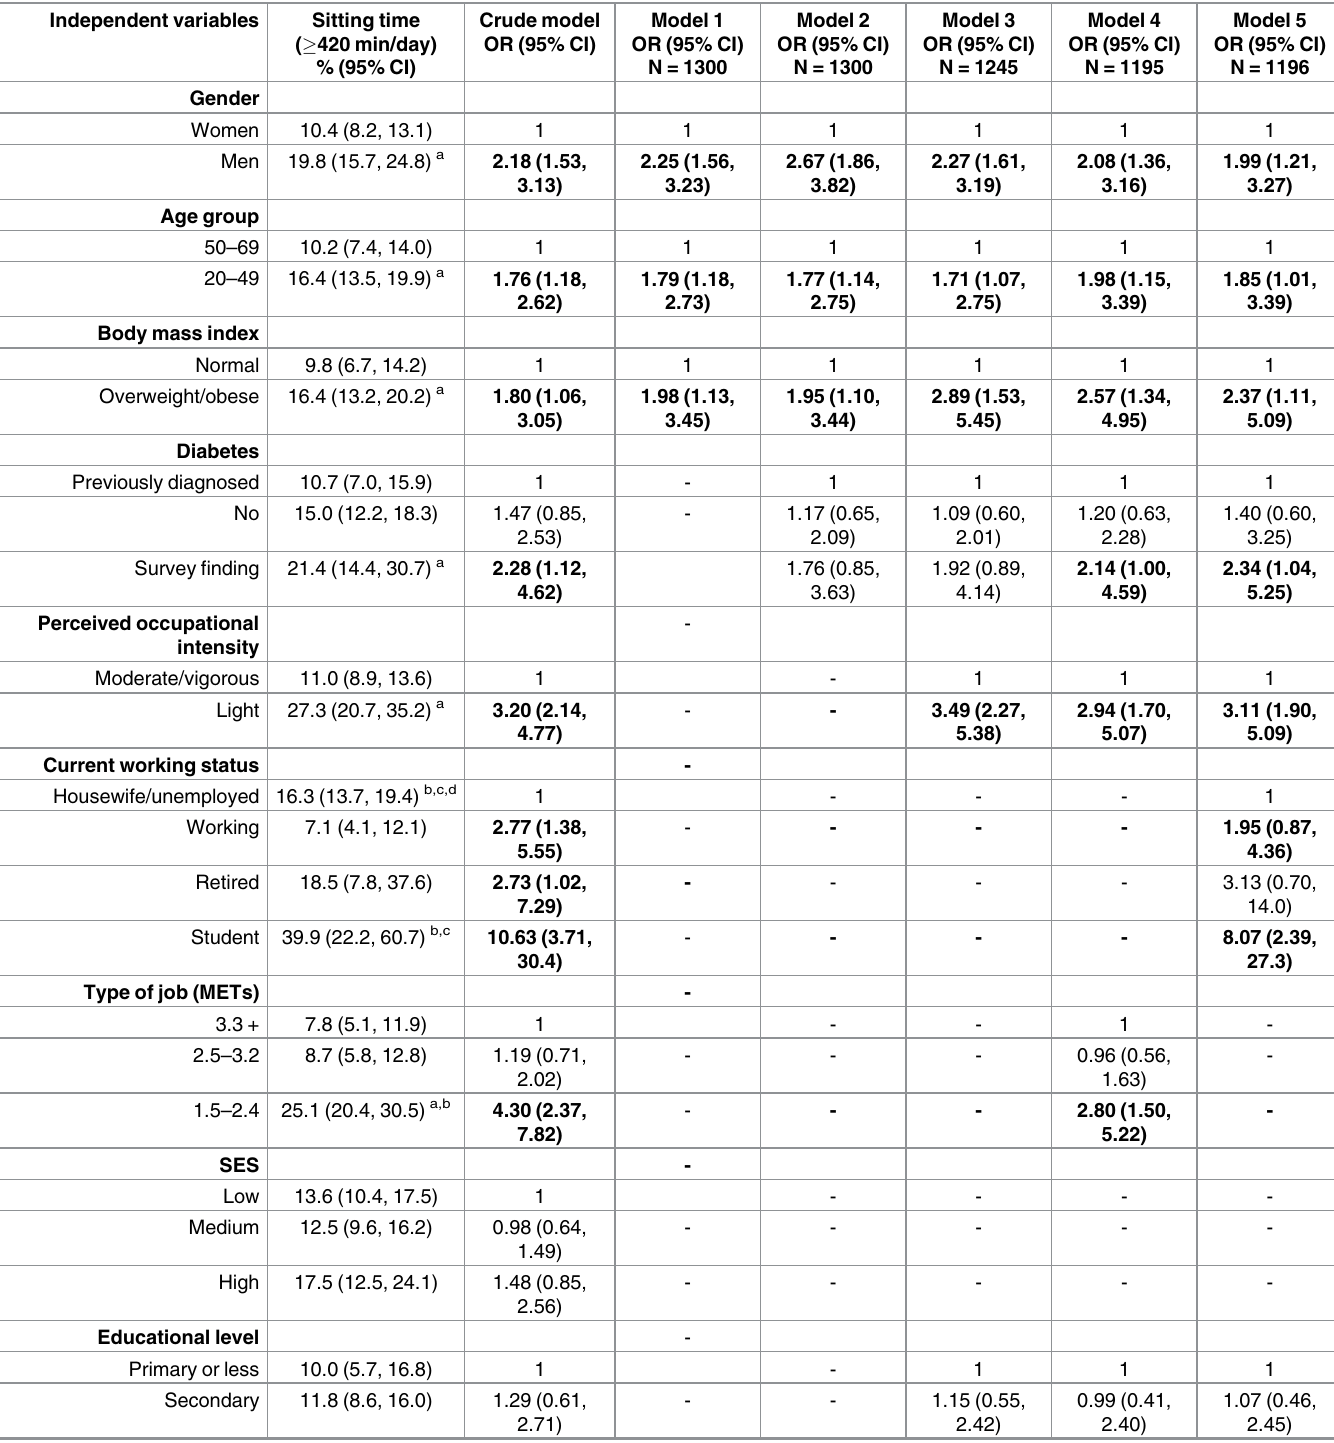
Table 3. Crude and adjusted odds ratios (OR) of being in the highest sitting category ( (cid:21) 420 minutes/day), MCDRS, Mexico City, 2015. Independent